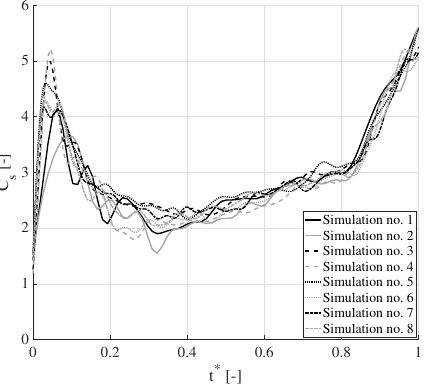
Figure 7. Magnification of Figure 6 referring to the first impact phases. Black curves are related to low Re, gray ones to high Re. Solid line refers to D = 50LU, dashed ones to D = 100LU, dotted ones to D = 150LU and dash-dotted ones to D = 200LU.